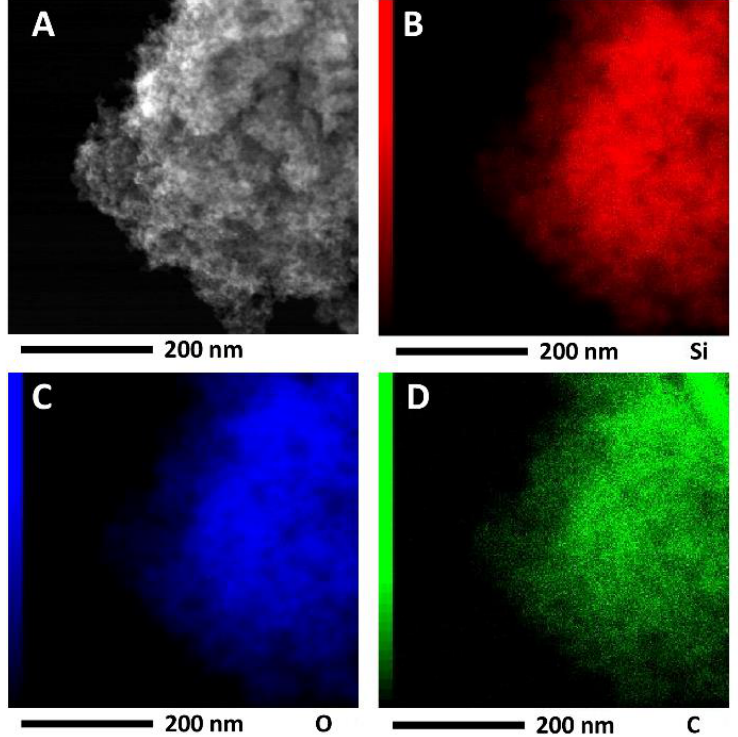
Figure 5. Transmission electron micrograph of the tannin silica aerogel (TS 0 . 15_6_10 ) ( A ) and the distribution of silicon (red, ( B )), oxygen (blue, ( C )) and carbon (green, ( D )) atoms throughout the sample, visualized by STEM images.